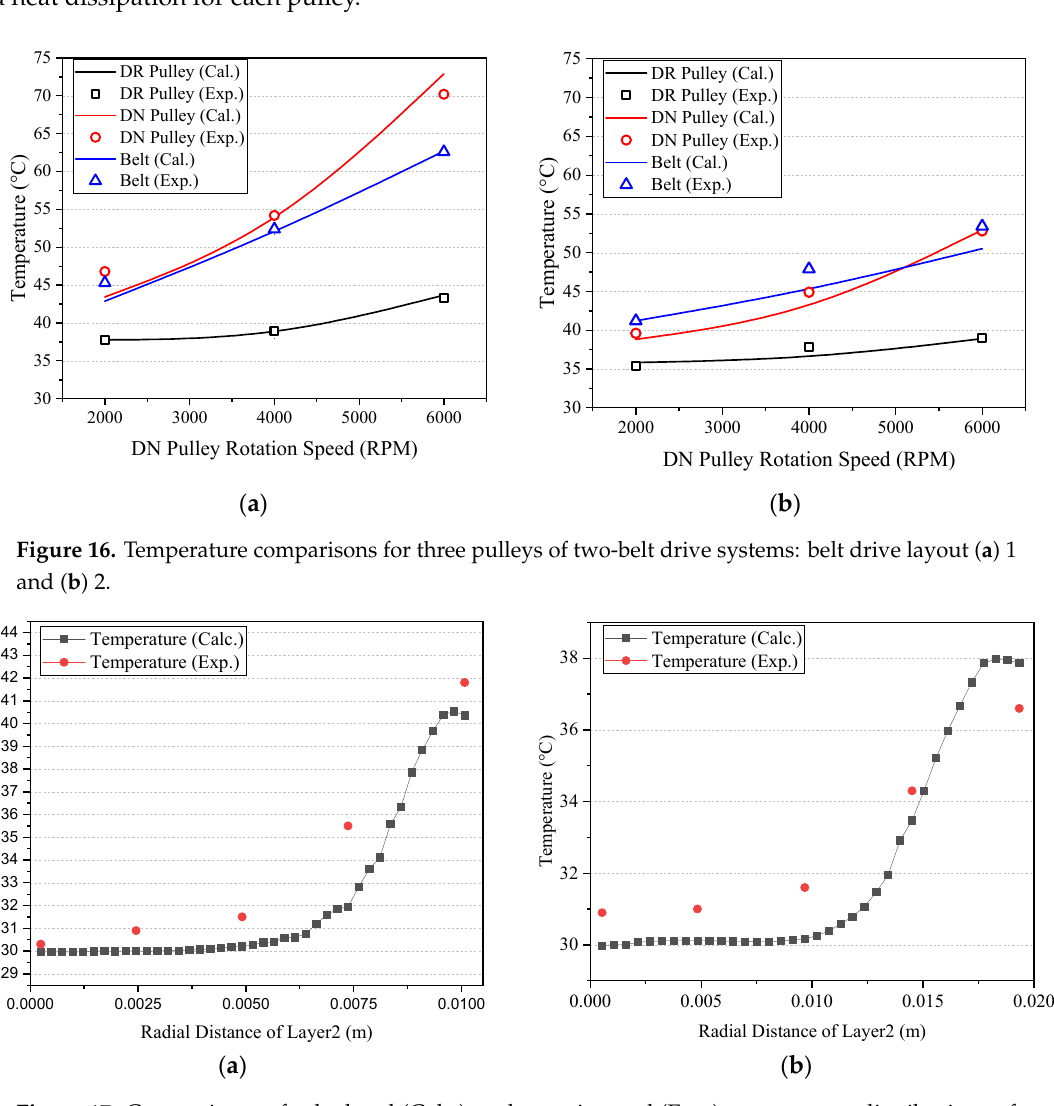
Figure 17. Comparisons of calculated (Calc.) and experimental (Exp.) temperature distributions of Layer 2 of two pulleys at a rotation speed of 6000 RPM and torque load of 10 N · m: pulley with diameter of ( a ) 76.2 mm and ( b ) 108 mm.